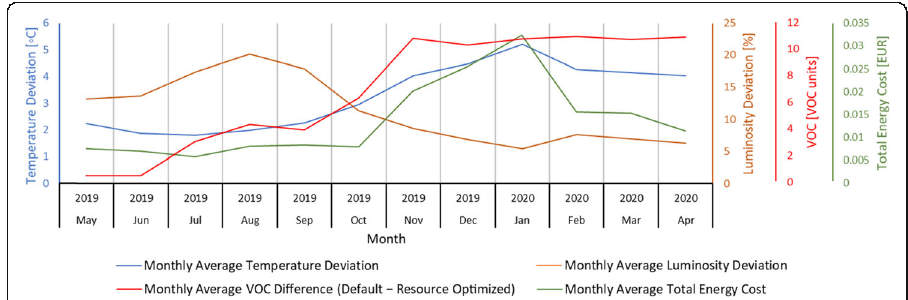
Fig. 4 Comparison between the four main equations: temperature deviation, luminosity deviation, VOC difference, and total energy